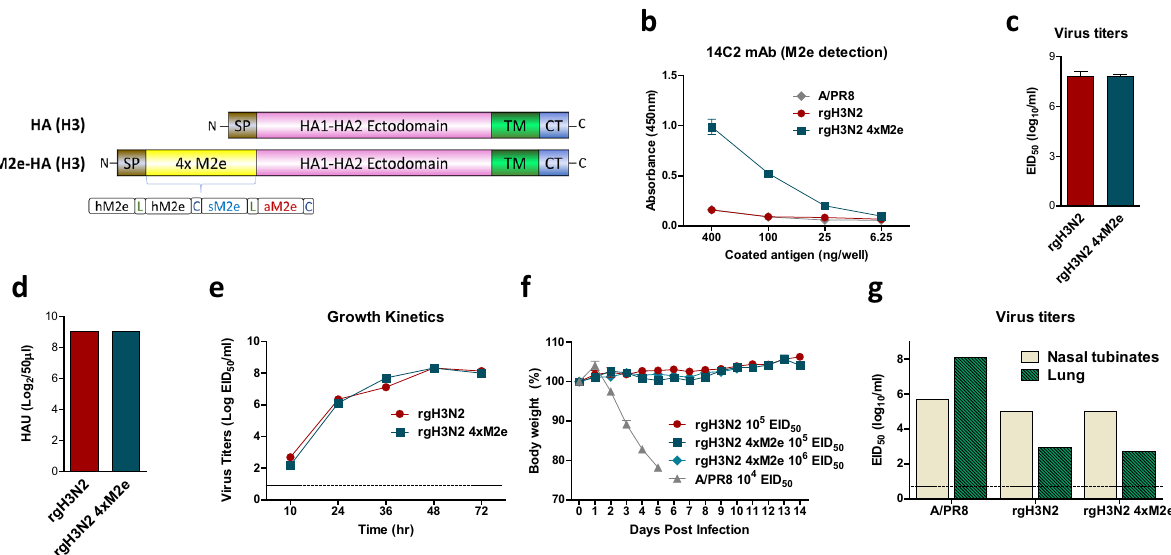
Figure 1. Reassortants rgH3N2 and rgH3N2 4xM2e virus expressing chimeric 4xM2e-HA are attenuated in vivo . ( a ) Diagram for chimeric 4xM2e-HA (H3) structures. The sequence H3 HA was derived from A/ Switzerland/2013 (H3N2). SP: signal peptide, tandem repeat 4xM2e is composed of human, swine, and avian influenza A viruses. hM2e: SLLTEVETPIRNEWGSRSNDSSD, sM2e: SLLTEVETPTRSEWESRSSDSSD, aM2e: SLLTEVETPTRNEWESRSSDSSD. L and C represent linker (AAA GGA A) and connector (AAAPGAA) respectively. ( b ) 14C2 M2e specific mAb ELISA assays were performed to characterize 6:2 reassortants rgH3N2 and rgH3N2 4xM2e viruses (4 µg/ ELISA plate well) generated by reverse genetics (rg) using the A/ PR8 backbone. ( c ) Infectious virus titer averages (EID 50 ) of rgH3N2 (2 replicates) and rgH3N2 4xM2e virus (3 replicates) preparations in egg substrates. ( d ) Hemagglutination activity units (HAU, log 2 /50 µl) for rgH3N2 and rgH3N2 4xM2e viruses using chicken red blood cells. There was no variation in these two replicates that showed the same results on HAU assays. ( e ) Growth kinetics of reassortant viruses in embryonated chicken eggs at 33 °C infected with 10 4 EID 50 of rgH3N2 and rgH3N2 4xM2e. ( c – e ) A representative out of 2 repeats. ( f ) Body weight changes in BALB/c mice (n = 10, too small variations to be shown) IN inoculated with reassortant rgH3N2 viruses (10 5 –10 6 EID 50 ) or A/PR8 (10 4 EID 50 ). ( g ) Infectious virus titers (EID 50 ) in nasal turbinates and lung extracts from mice (n = 3, pooled) at 3-day post infection with A/PR8 (10 4 EID 50 ), rgH3N2 (10 6 EID 50 ) and rgH3N2 4xM2e (10 6 EID 50